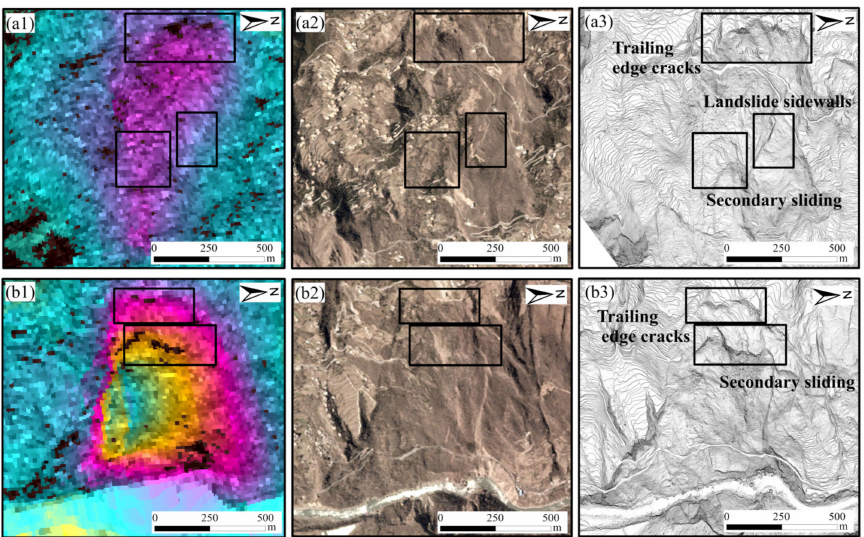
Figure 7. Detailed comparison of the three results from the multi-remote sensing technologies: ( a1 , b1 ) is the result of InSAR, ( a2 , b2 ) is the result of optical image sensing, ( a3 , b3 ) is the result of LiDAR.